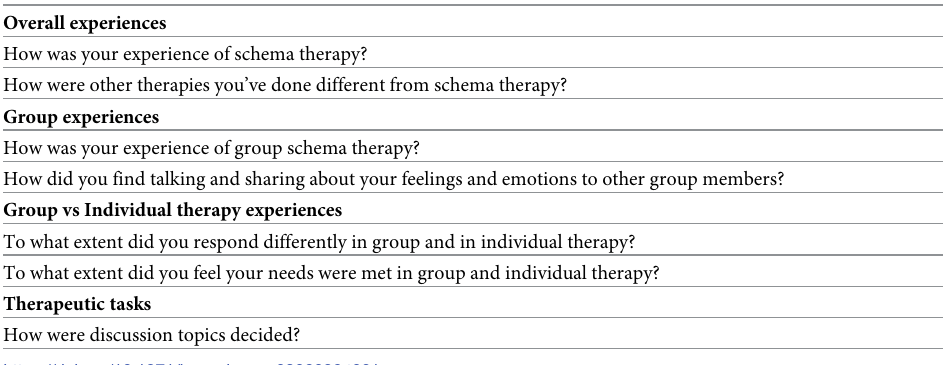
Table 1. Examples of interview questions in topic